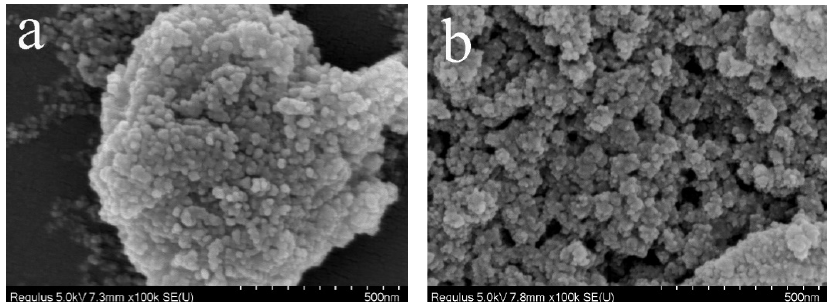
Figure 6. ( a ) Scanning electron microscopy (SEM) images of TiO 2 , and ( b ) SEM images of TMP ‐ TiO 2 .